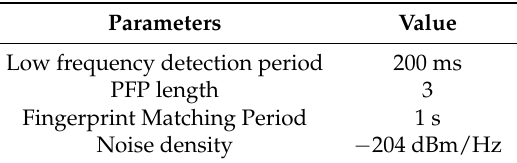
Table 2. Simulation parameters No.